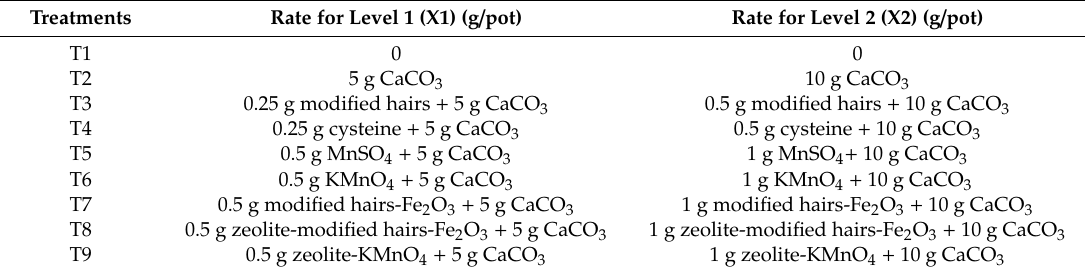
Table 1. Treatments and application rates of amendments in the